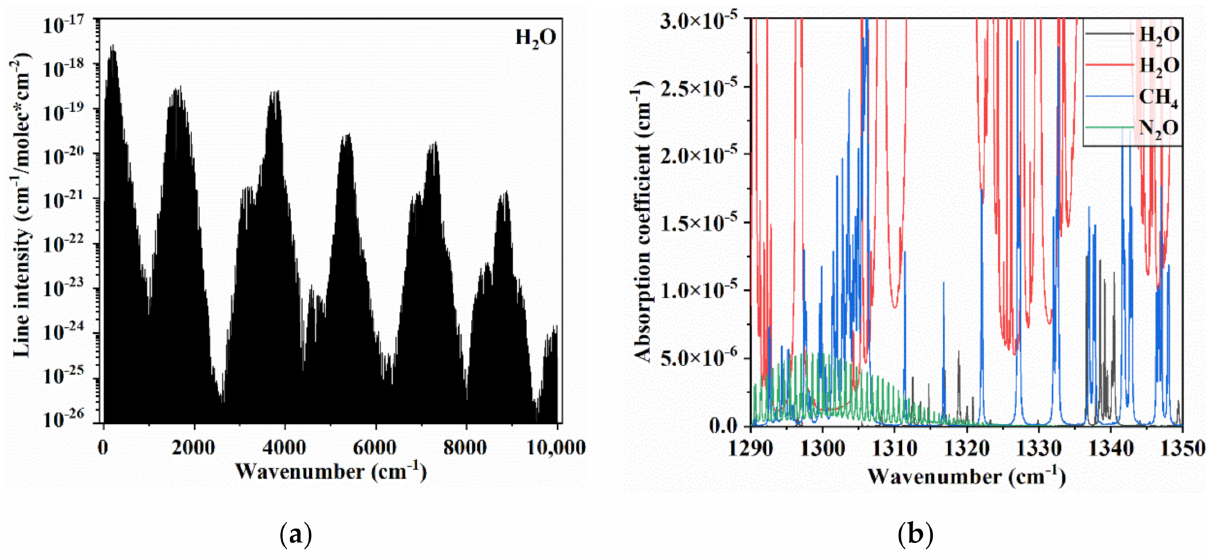
Figure 1. ( a ) The spectral lines of H 2 O from HITRAN2016 at 1 atm pressure and 296 K temperature. ( b ) The absorption coefficients of 2 ppmv CH 4 , 0.3 ppmv N 2 O, and 10 ppmv as well as 1.4% H 2 O at 1 atm pressure and 296 K temperature using HITRAN database data and Voigt linear